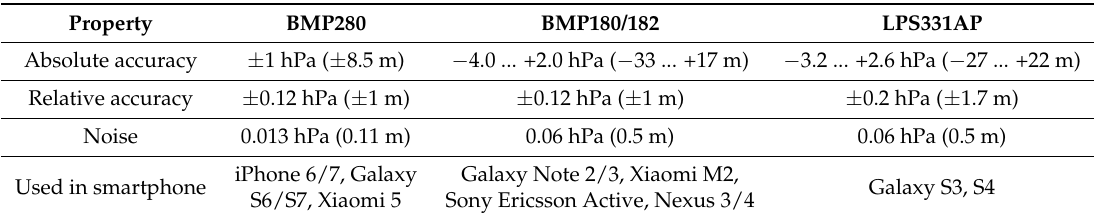
Table 1. Barometer sensor